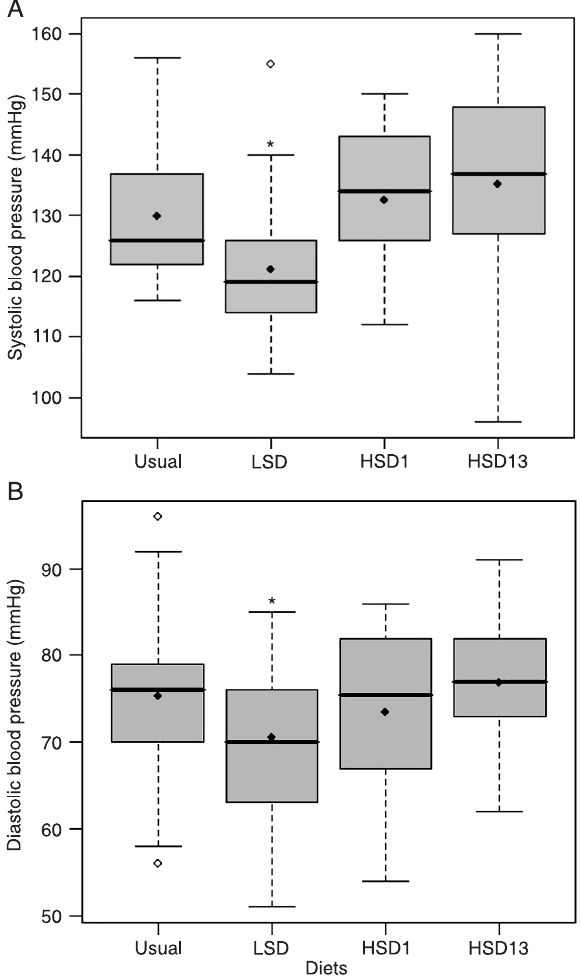
Figure 1. Systolic (A) and diastolic (B) blood pressures of sub- jects on different salt diets. Box plots indicating the median (thick line), the mean (filled lozenges), and range of blood pressure of subjects on their usual diet (215.24 ± 133.08 mmol sodium/day), on a low-salt diet (LSD, 70.03 ± 57.97 mmol sodium/day), and after 1 week (HSD1, 297.75 ± 112.75 mmol sodium/day) and 13 weeks (HSD13, 294.71 ± 104.83 mmol sodium/day) on a high- salt diet. The boundaries of the box indicate the lower and upper quartiles. Open lozenges: Outliers with values between 1.5 and 3 box lengths from the boundaries of the box. A: *P = 0.01 vs usual, and P < 0.01 vs HSD1 and HSD13 (mixed linear model test). B: *P = 0.03 vs usual, and P = 0.01 vs HSD13 (mixed linear model